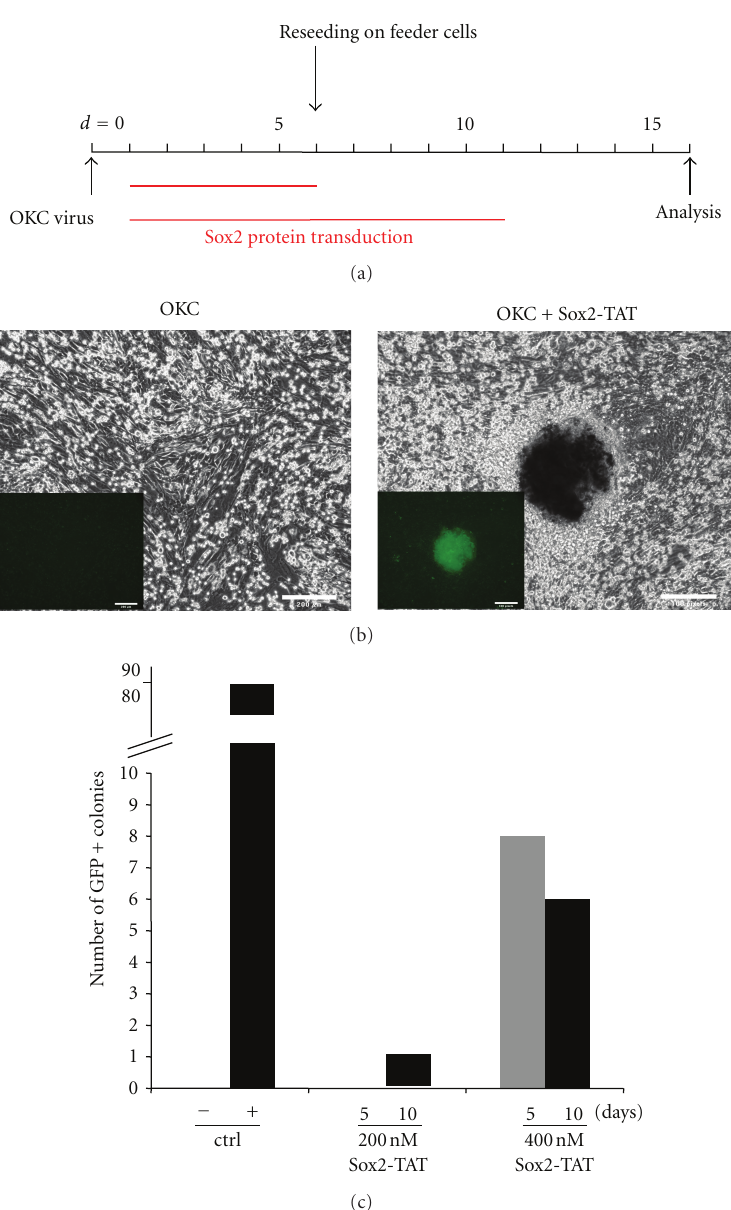
Figure 3: Reprogramming of MEFs using cell-permeant Sox2-TAT protein. (a) Schematic presentation showing the timeline of reprogramming setup. Oct4-GiP MEFs were infected with viruses encoding Oct4, Klf4, and c-Myc (OKC) at day 0. Starting at day 1 post infection (p.i.), cells were incubated with Sox2-TAT for 5 and 10 days, respectively, changing the Sox2-TAT-supplemented media daily. (b) Representative pictures of cells transduced with 200 nM Sox2-TAT protein (right panel) displaying phase contrast and GFP channel (inset) 14 days p.i. OKC-infected cells treated with medium only served as controls (left panel). Scale bar = 100 μ m. (c) Quantification of GFP-positive colonies at day 16p.i. OKC-infected cells ( − ) as well as SOKC-infected cells (+) served as